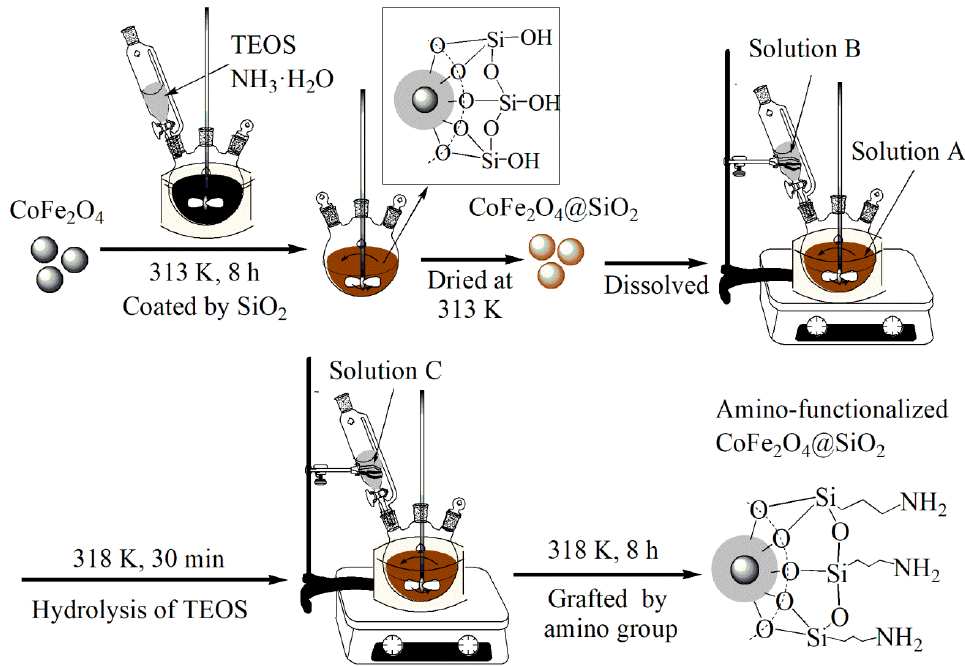
Figure 1. Synthesized schematic diagram of CoFe 2 O 4 @SiO 2 –NH 2 and silanization reaction between silica and 3-aminopropyltriethoxysilane (APTES).